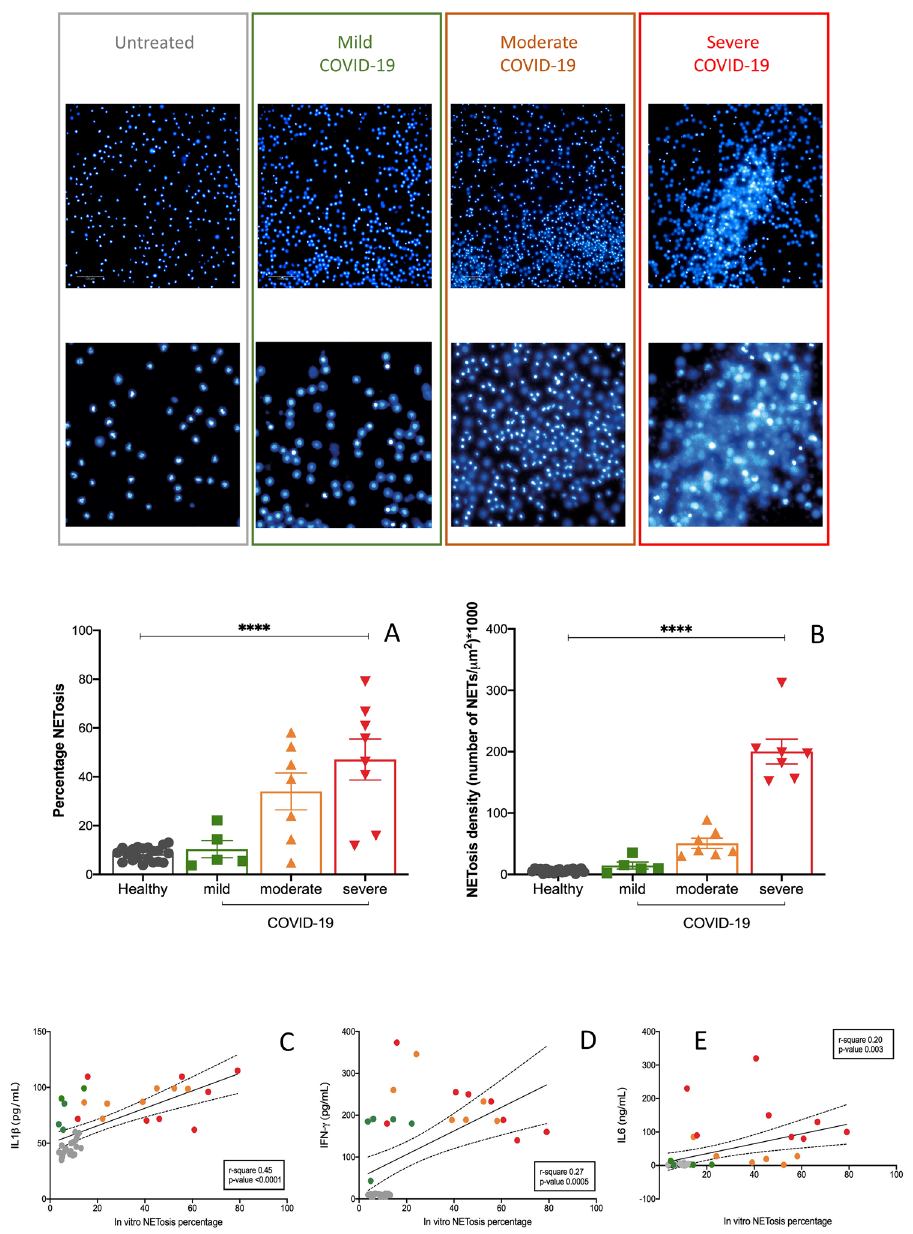
Figure 7. Profiling of immune cells and NETosis in mild-moderate COVID-19 in not vaccinated and in vaccinated patients. High density neutrophils were isolated from three healthy subjects using a density gradient as described in Methods and previously 44–46 ; purity was assessed as shown in Supplementary Fig. 1. After isolation, HDNs were maintained in culture with 10% FBS complete RPMI media for 2 h and exposed to sera obtained from COVID-19 subjects, not vaccinated (red squares) or fully vaccinated (blur triangles) for 3 h. Immune profiling was assessed by flow cytometry to evaluate the absolute numbers of CD3 + CD4 + T-cells ( A ), CD3 + CD4 + CD45RO + T-cells ( B ), CD3 + CD8 + T-cells ( C ), CD3 + CD8 + CD45RO + T-cells ( D ), CD14 + HLA-DR - monocytes ( E ) and their percentage ( F ). DAPI and cit-H3 staining of DNA revealed the presence of neutrophil extracellular traps (NETs), as shown in the lower panel (I) . (G) percentage of NET-s and (H) NET density was quantified and plotted. Bars represent mean and standard deviation. Stars denote statistical significance when t-Student test for unpaired data was applied, *p < 0.005, **p < 0.001. In experiments using sera from vaccinated patients 5 nM ramipril was added in culture for 1 h before to add patients’sera and NETs detected by immunofluorescence as previously described. A representative image of NETs induced by COVID-19 sera of a vaccinated patient is shown in L panel and its drastic reduction when ramipril was included in the treatment (M panel). Changes in NETs percentage and density have been quantified and plotted respectively in panels N and O. Stars denote statistical significance when t-Student test for paired data was applied, ****p < 0.0001. NETs neutrophil extracellular traps, nM